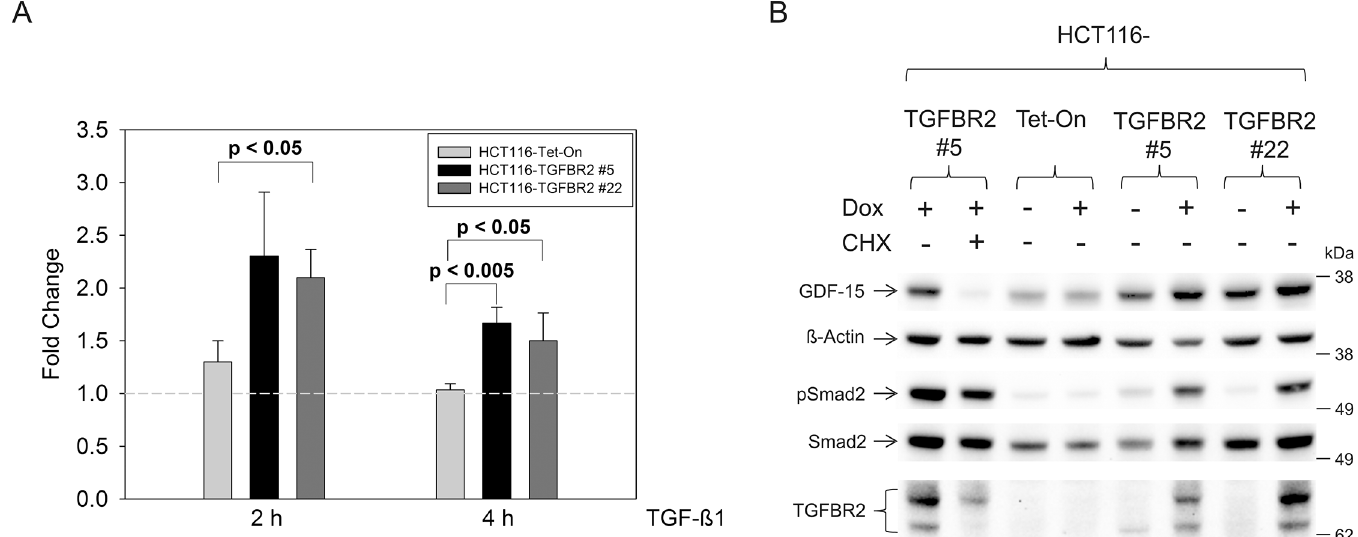
Fig 1. Expression analyses of GDF-15. (A) Upregulated transcript levels of GDF-15in the presence of Dox using real-time qRT-PCR analysis. (B) Western blot analysis of GDF-15 protein expression in total protein lysates (30 μ g) of TGF-ß1 stimulated cells (4 h). Expression of GDF-15is increasedwhen TGFBR2 is expressed (+Dox) in both cell clones but not in the parentalTet-On cell line. TGF-ß1 signaling is indicated by increased pSmad2 levels in the TGFBR2-expressing clones. Addition of cycloheximide (CHX) reduces the expression level of GDF-15. ß-Actin and Smad2 servedas a loading control.